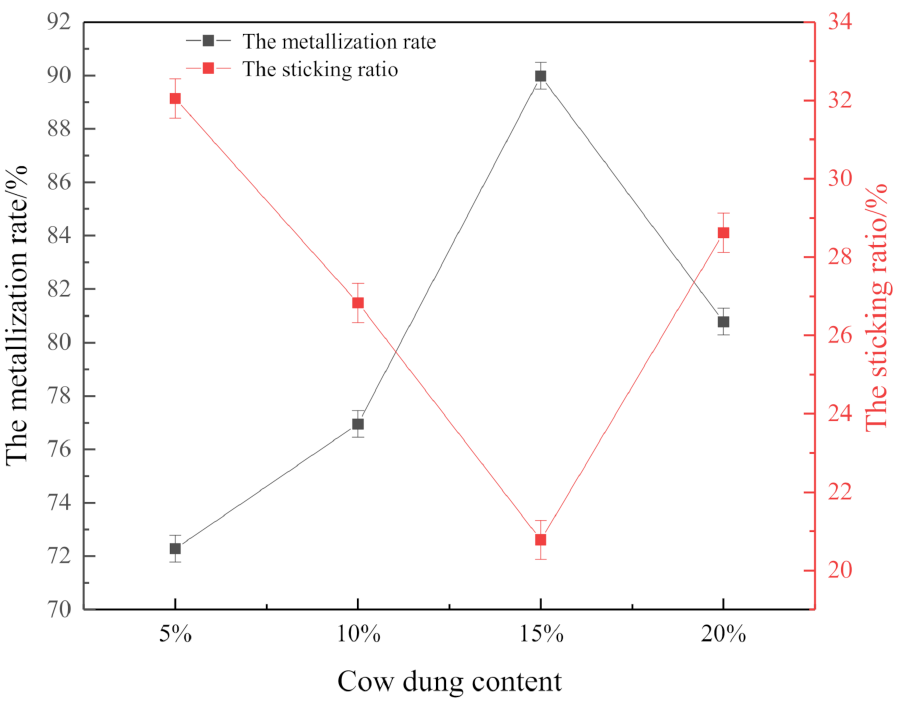
Figure 6. Cow dung for Newman mine metallization rate and binder ratio affect the line chart change with content.